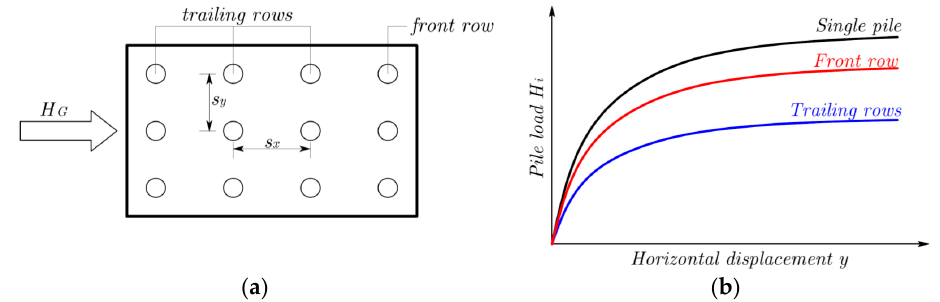
Figure 1. ( a ) Front and trailing rows in laterally loaded pile group ( H G —total lateral force acting on pile group, s x and s y —center-to-center spacing between the piles in X and Y directions, respectively); ( b ) Influence of the “shadowing” on the load distribution inside the pile group ( H i —lateral force acting on pile i ).